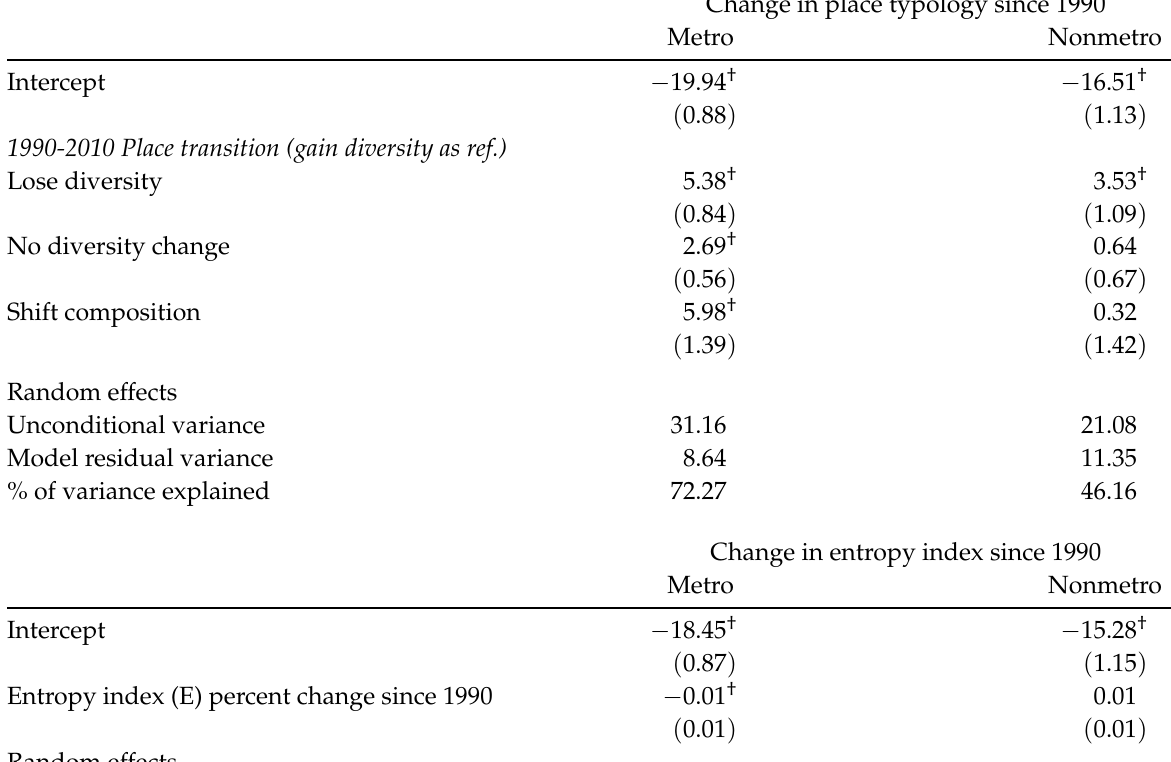
Table 8: Fixed and Random Effects from HLM Regressions of Percent Change in B-W Segregation ( D ) on Place Transition, Net of Place and Metro(Nonmetro) Factors, 1990-2010